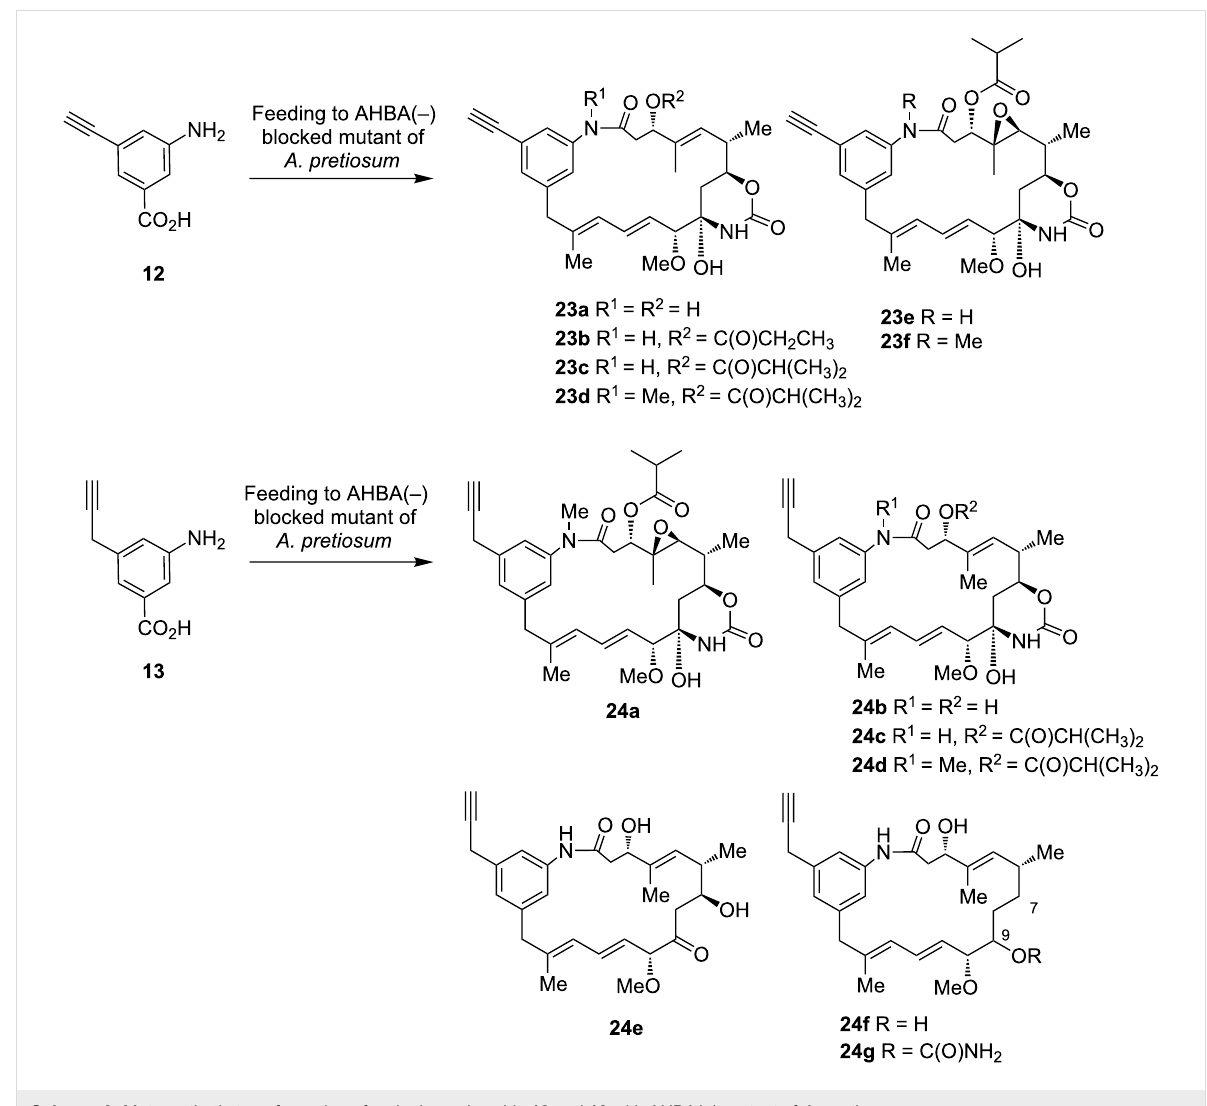
Scheme 6: Mutasynthetic transformation of aminobenzoic acids 12 and 13 with AHBA( − )-mutant of A. pretiosum.